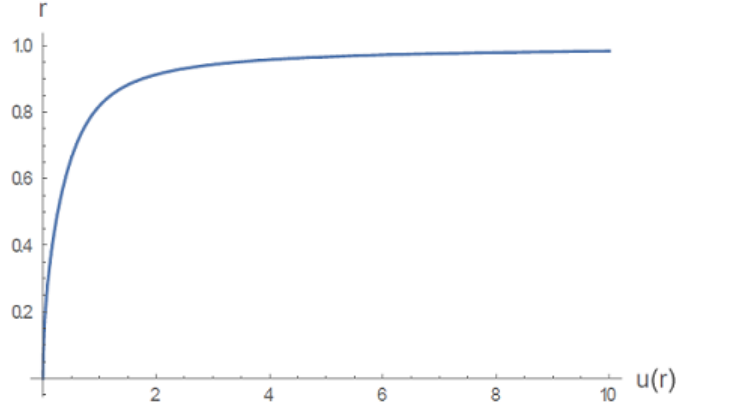
Figure 3. Universal radial distance as the inverse function of network potential energy u ( r ) in dimensionless units